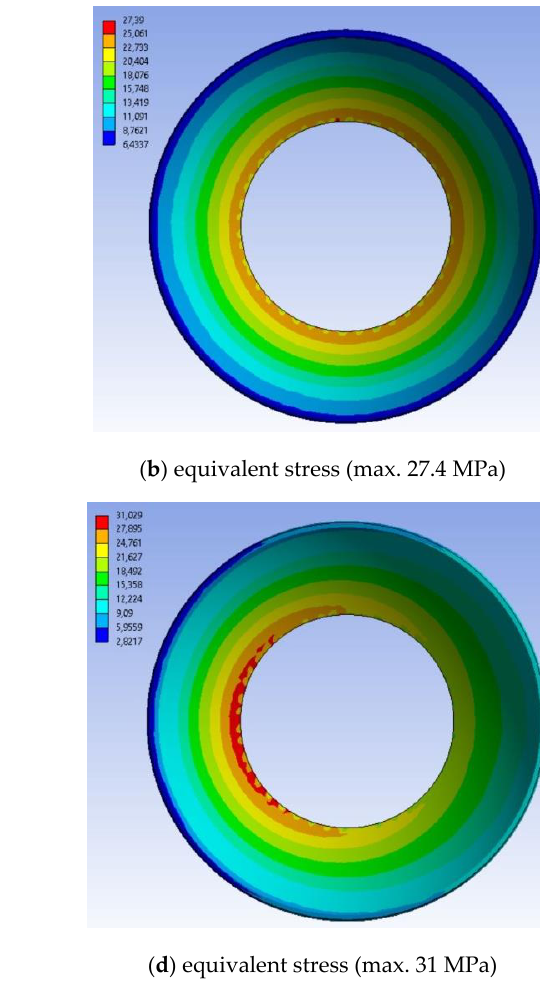
Figure 7. Polymer liner embedded without clearance, coefficient of friction μ = 0.1, vertical and lateral load components: